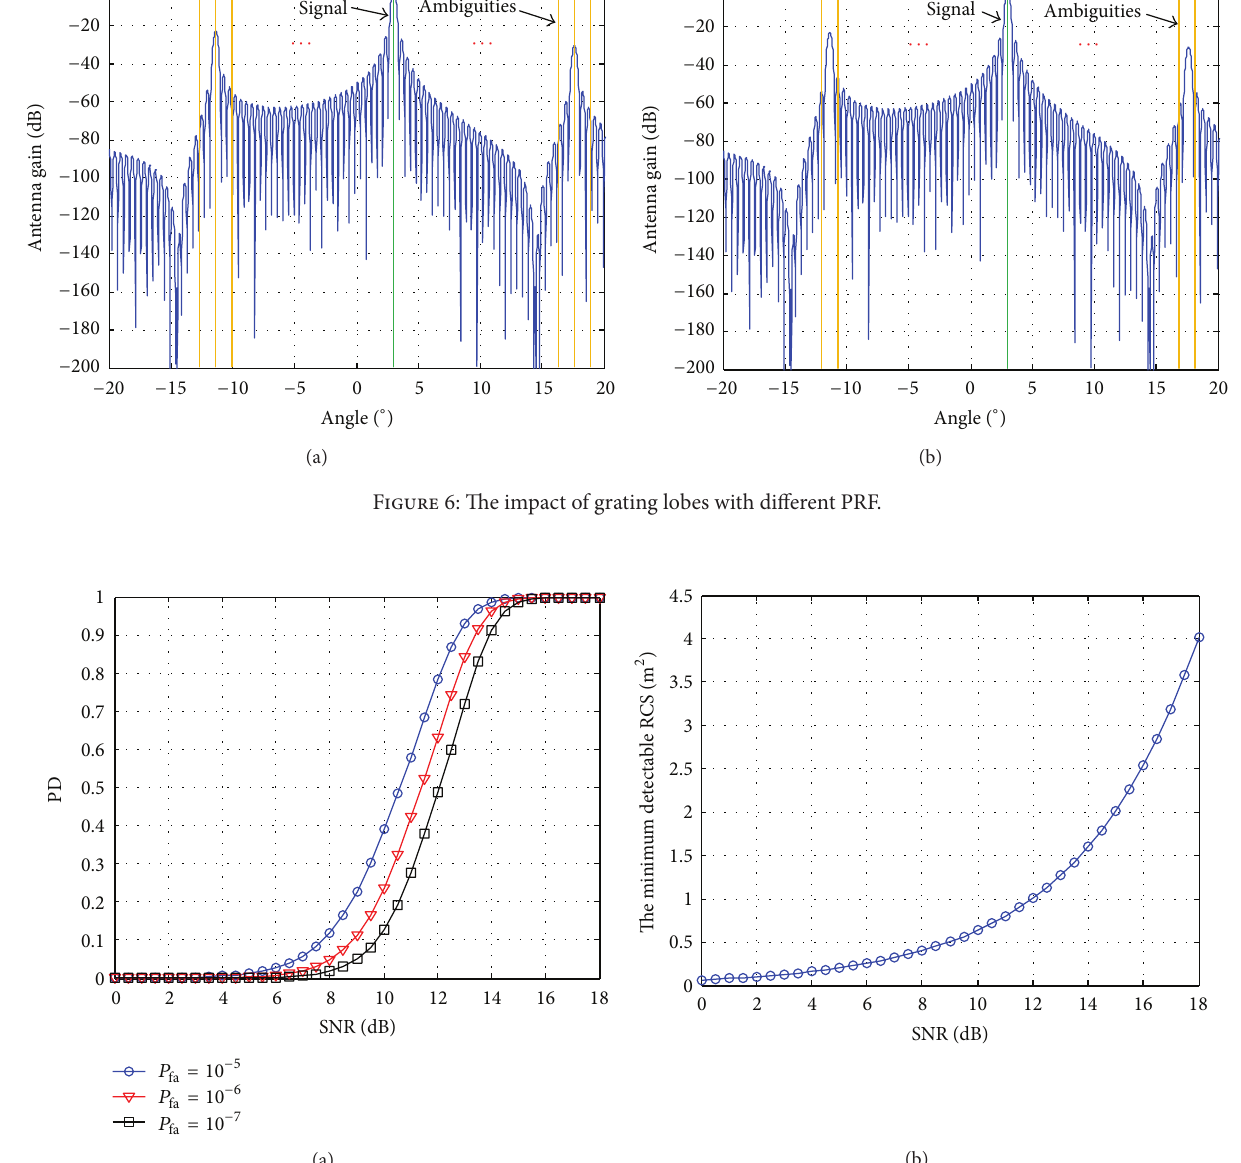
where 𝑃 𝑡 is the transmit power of the antenna, 𝐺 𝑡 represents the antenna gain, 𝜎 is the radar cross section of the target, 𝐴 𝑒 accounts for the effective antenna aperture, between the radar and the target, 𝑘 is Boltzmann’s constant, 𝐹 represents the receiver noise figure, 𝑇 system noise temperature, and 𝐵 𝑛 accounts for the receiver